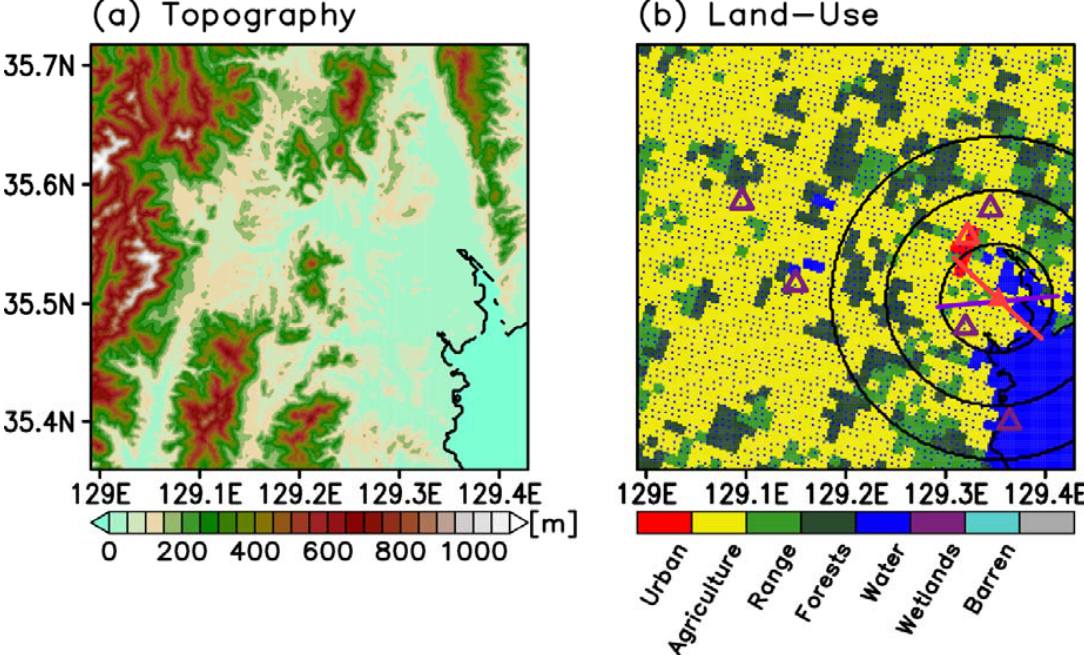
Figure 1. ( a ) Surface elevation of the study area, and ( b ) the land cover type. In ( b ), the locations of the surface Automated Surface Observing System (ASOS) station (open red triangle), automated weather stations (AWS) stations (open purple triangles), and the emission source (filled red triangle) are indicated. Three circles indicate the distances from the emission source as 5, 10, and 15 km.